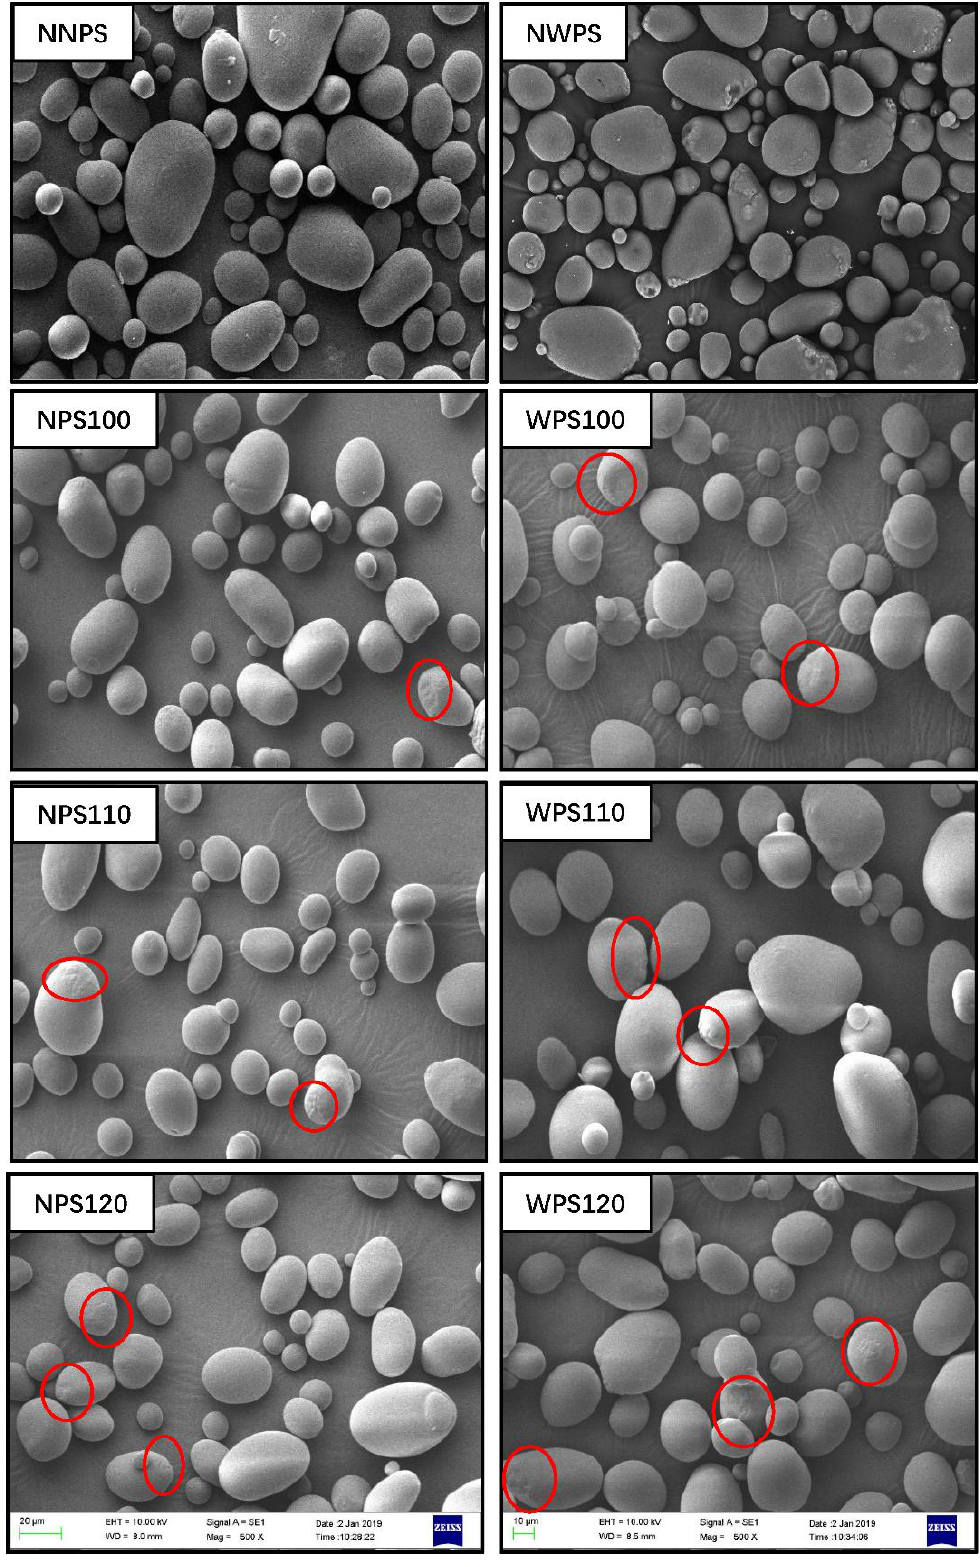
Figure 1. Scanning electron micrographs of the samples (500×) (Red circles were indicated change in the particle surface).